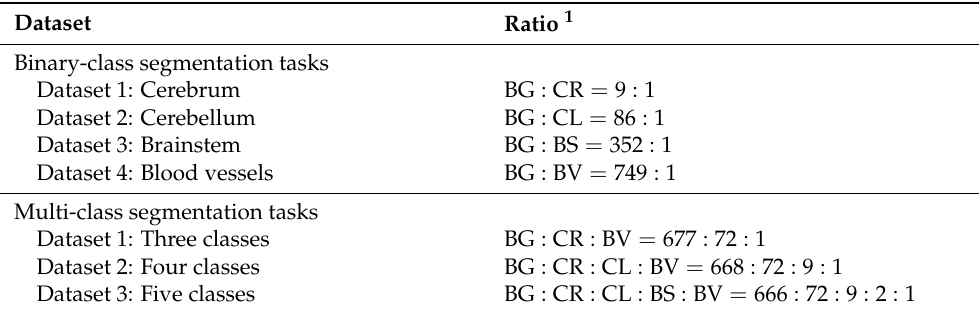
Table 3. Training datasets in binary- and multi-class segmentation tasks. BG, CR, CL, BS, and BV stand for background, cerebrum, cerebellum, brainstem, and blood vessels, respectively. Dataset Ratio